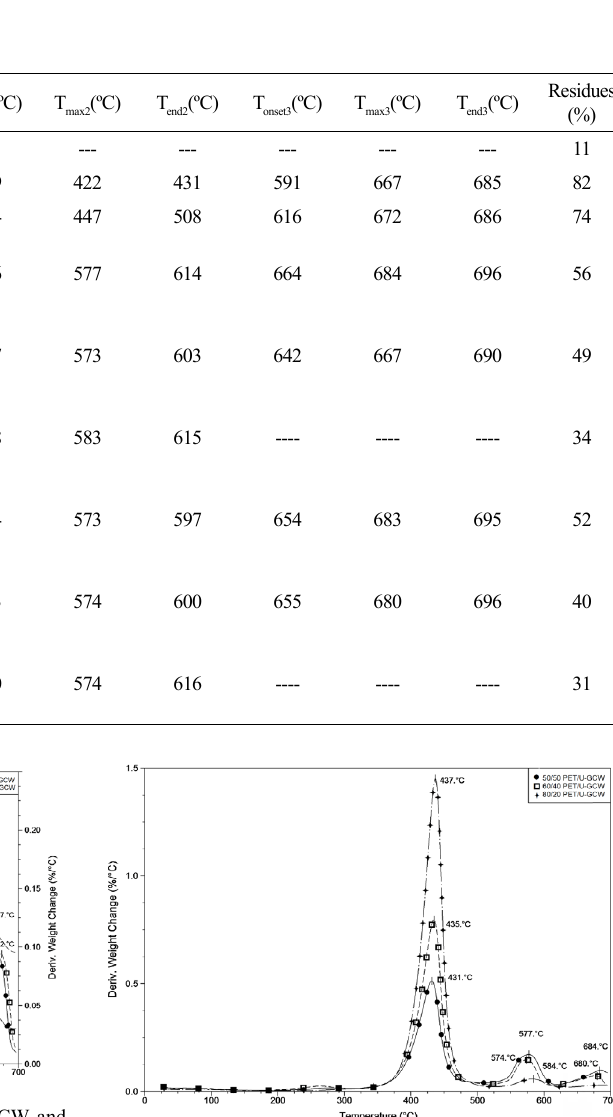
Figure 6. Overlay of the TG and DTG curves of T-GCW and GCW composites.